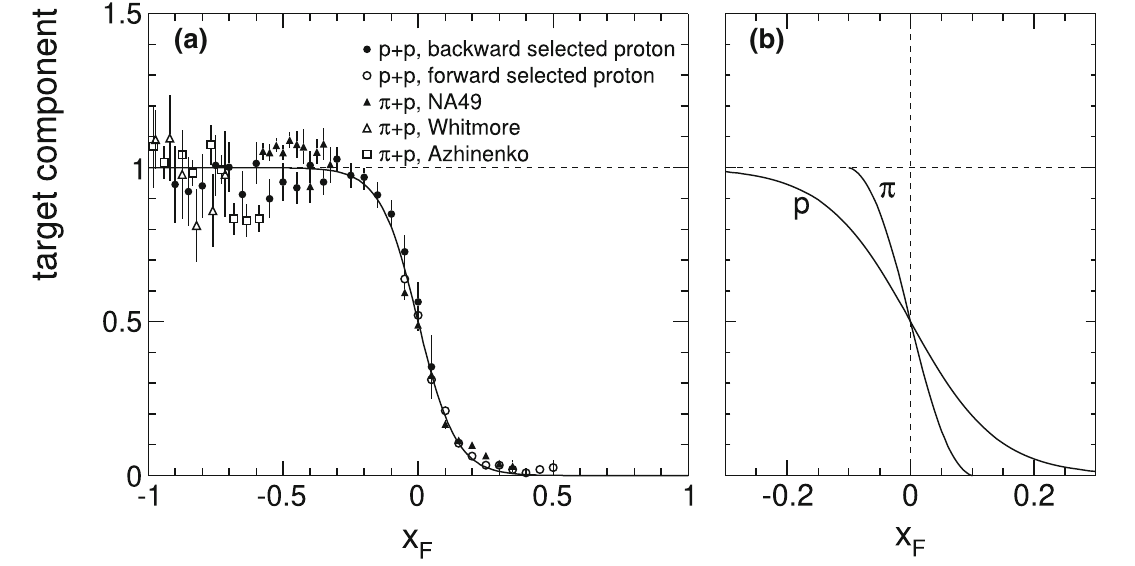
Fig. 133 a Target component for net protons measured with different methods and b target components of (cid:4) π (cid:5) and net